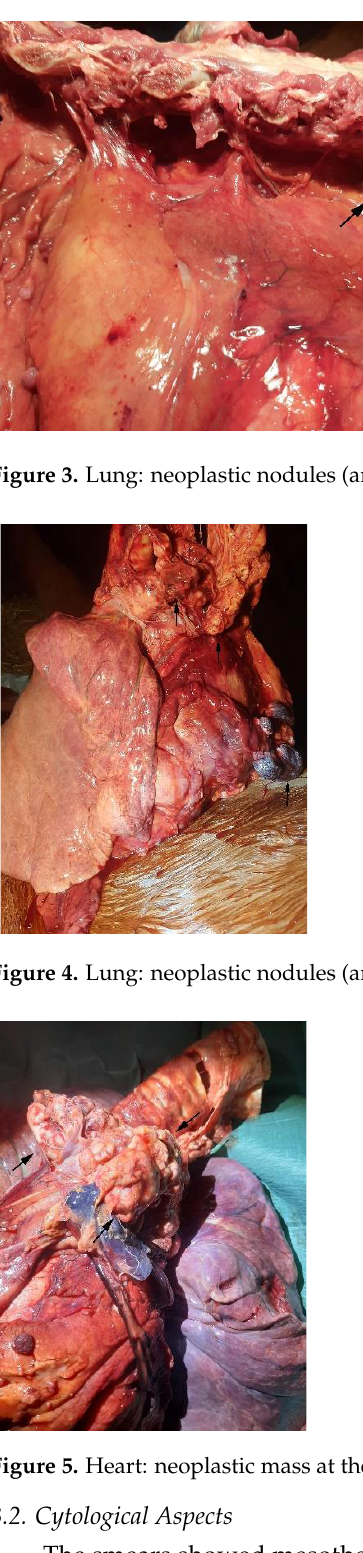
Figure 2. Abdominal cavity: dark red effusion and nodular masses, arranged in clusters.